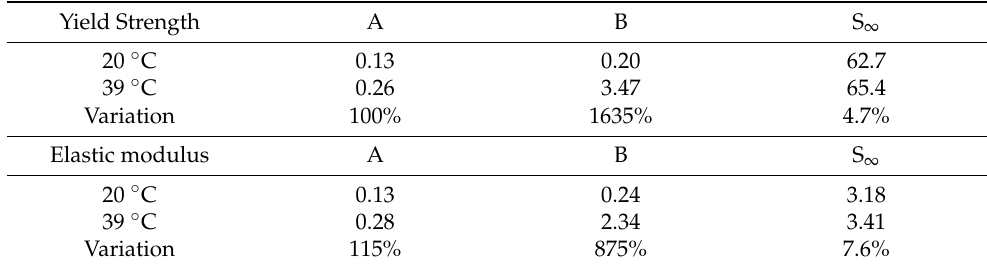
Table 2. Comparison of logistic fitting parameters for the yield strength and elastic modulus on samples aged at 20 ◦ C and 39 ◦